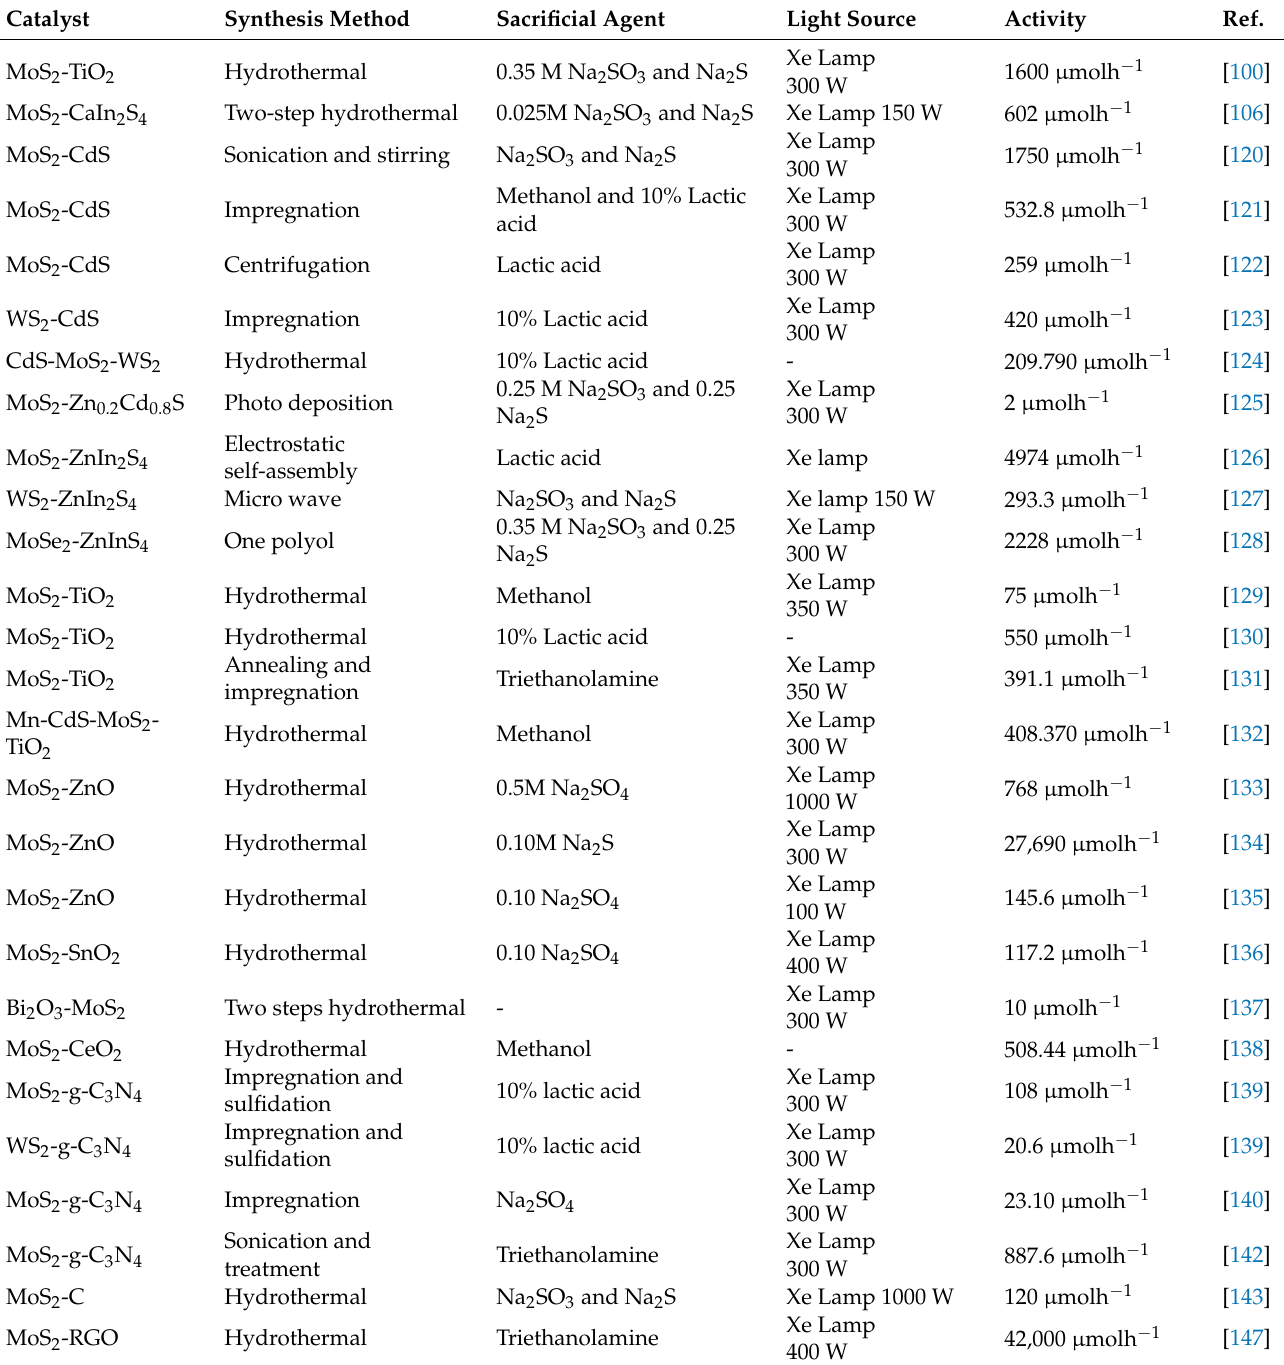
Table 1. Role of TMDC as a good promoter of catalysts in hydrogen evolution